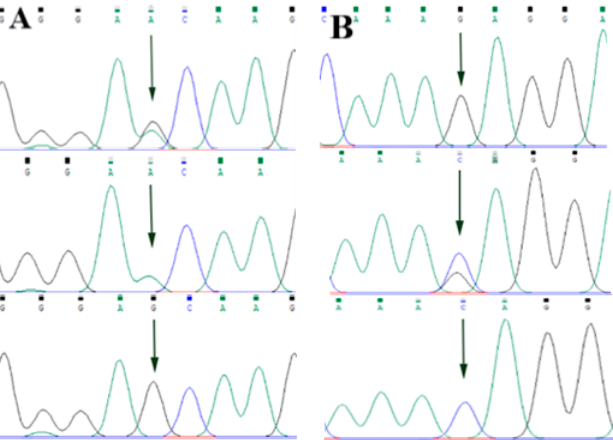
Figure 4. Sequencing peak map of two SNPs in SPP1 gene sequence. The sequence map at SPP1 -g.50265G > A site for GA, GG and AA ( A ), The sequence map at SPP1 -g.50315C > T site for CT, TT and CC ( B ). The arrow indicates the location of the mutation sites.